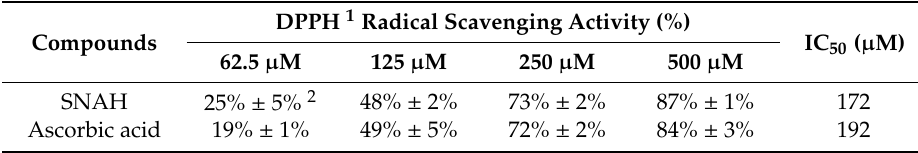
Figure 5. Effects of SNAH on LPS-induced ROS (reactive oxygen species) production. ( a ) RAW 264.7 cells were pretreated with 10–100 µ M SNAH for 1 h before treatment with 1 µ g / mL LPS for 18 h. Cells were incubated with 10 µ M 2 (cid:48) ,7 (cid:48) -dichlorofluorescein diacetate (DCFH-DA) for 30 min at 37 ◦ C. Then, cells were harvested, and dichlorofluorescein (DCF) fluorescence was immediately analyzed by flow cytometry. DCF fluorescence intensity was determined from the same numbers of cells in a randomly selected area. ( b ) The mean relative ROS level is presented in a bar graph. The values are presented as means ± SD of three independent experiments ** p < 0.01, compared to the LPS-treated group. Table 1. DPPH radical-scavenging activity of the SNAH and IC 50